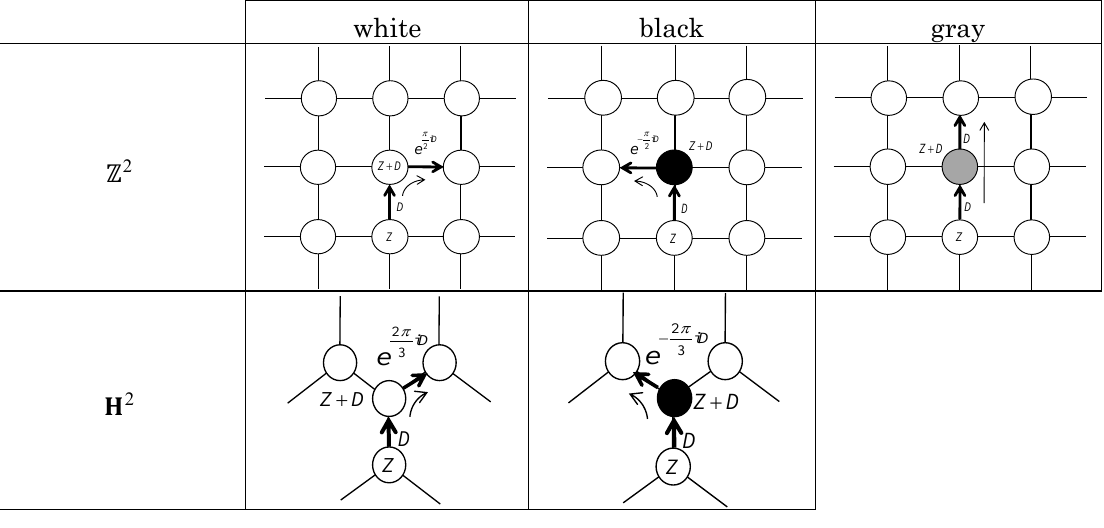
Figure 1. Transaction rules on each topology and each color of the cell that the ant is heading to. white black